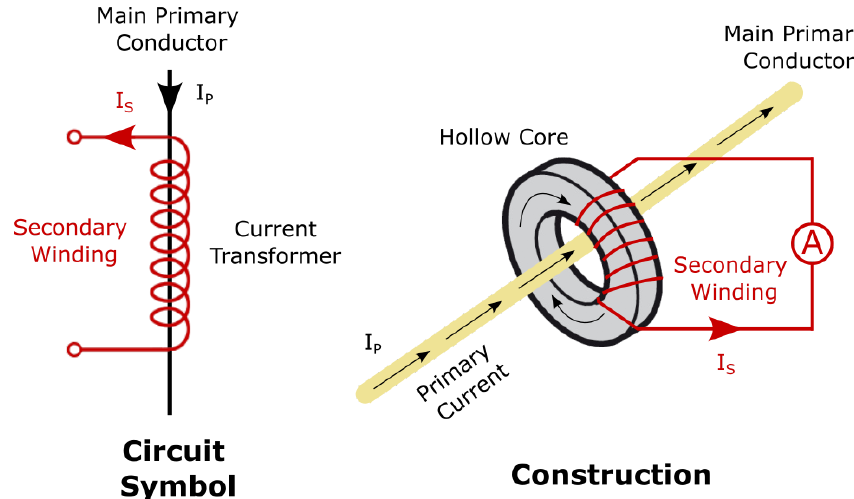
Figure 3. Current transformer working